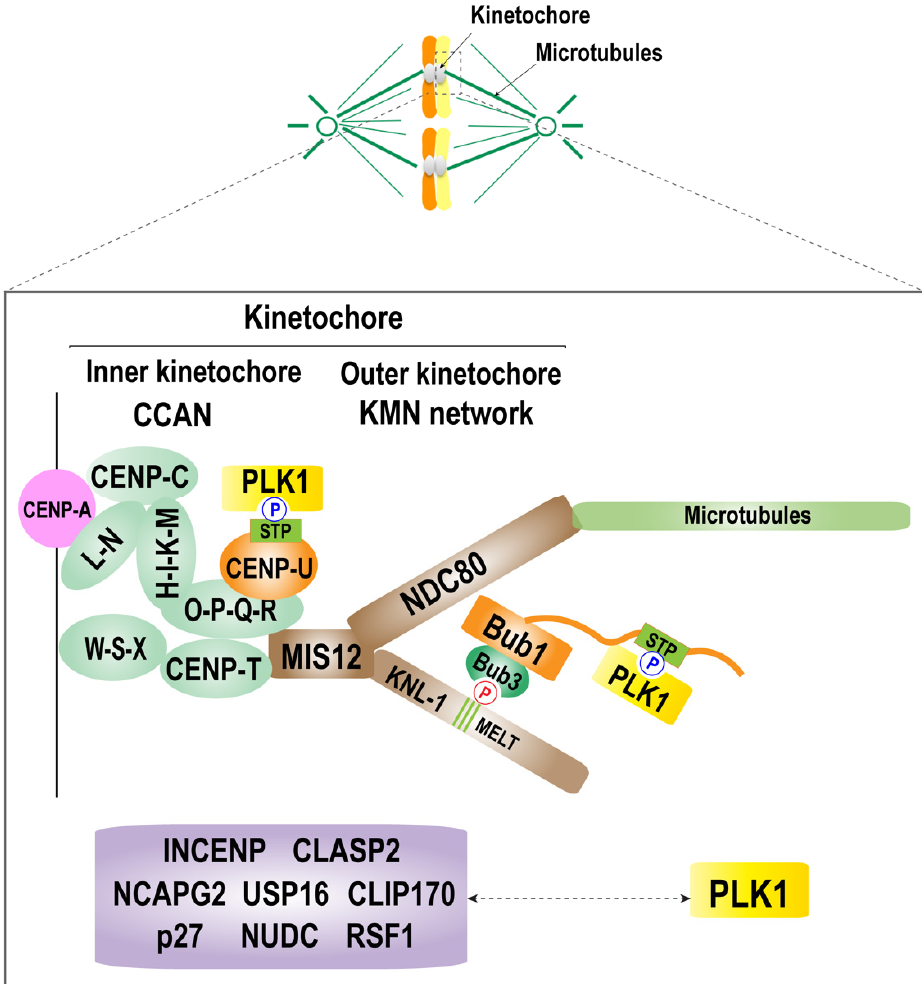
Figure 2. Molecular mechanism of PLK1 localization at the kinetochore. A schematic diagram of the kinetochore structure and the mechanism of kinetochore recruitment of PLK1. The kinetochore consists of an inner and an outer kinetochore. The inner kinetochore is composed of a complex of CCAN, CENP-C, CENP-HIK-LN, CENP-T, and CENP-QU. The outer kinetochore is composed of KNL1 complex, Mis12 complex, and the NDC80 complex (KMN network). PLK1 is recruited to the kinetochore by interacting with CENP-U and Bub1, which are located in the inner kinetochore and outer kinetochore, respectively. There are other known PLK1 receptors, including the kinetochore components Bub1, BubR1, and CENP-U (also called PBIP1), and other proteins, including nuclear distribution protein C (NUDC), CLIP-170, dynactin subunit p27, INCENP, CLASP2, Survivin, NCAPG2, USP16, and RSF1. The relationship between PLK1 and these components during mitosis requires further characterization.